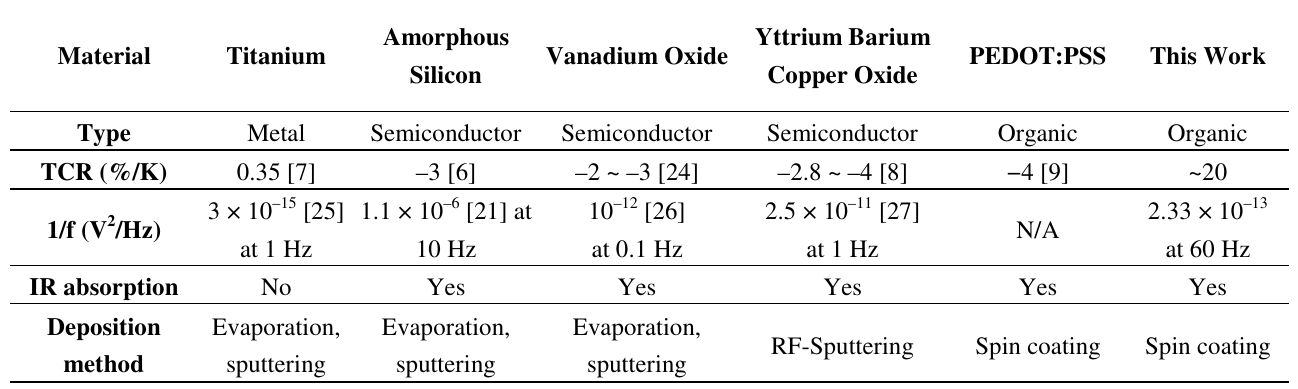
Table 1. Comparison of different IR sensing